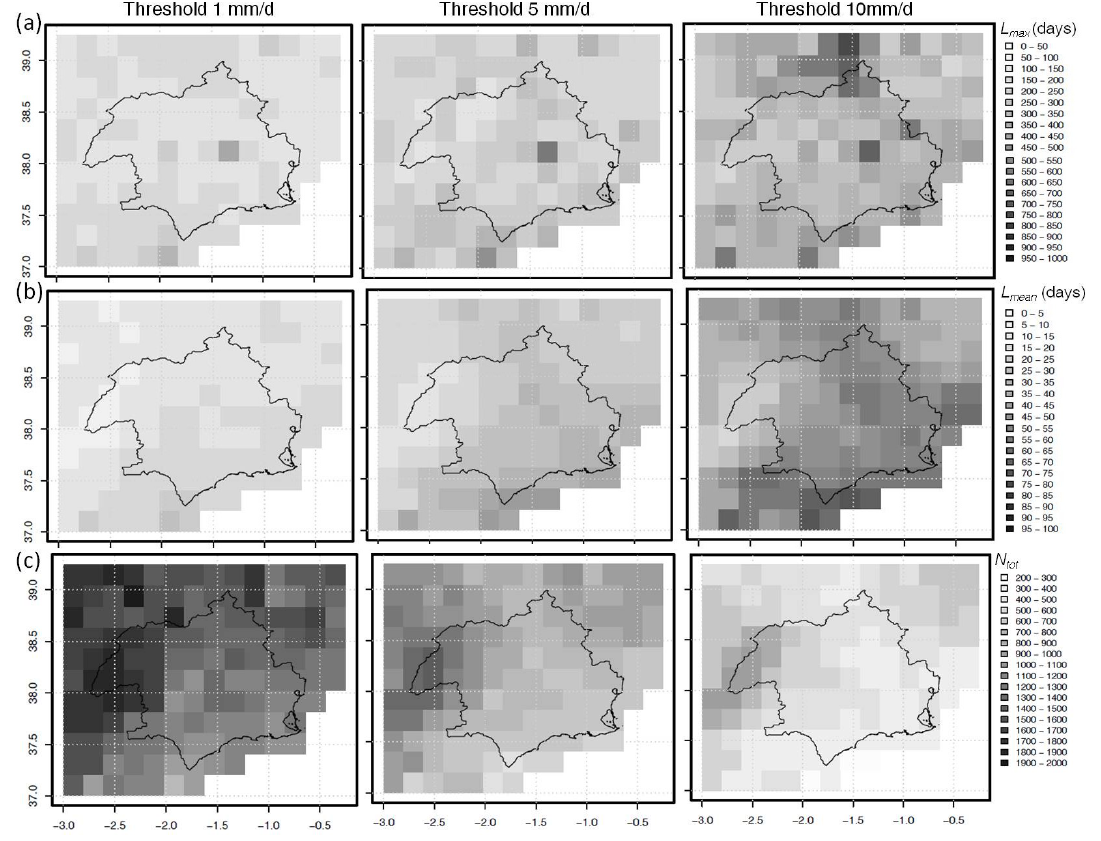
Figure 3. Spatial patterns of dry spells attributes for thresholds of 1 mm/day, 5 mm/day, and 10 mm/day: ( a ) maximum length ( L max ) in days; ( b ) mean length ( L mean ) in days; and ( c ) number of dry spells ( N tot